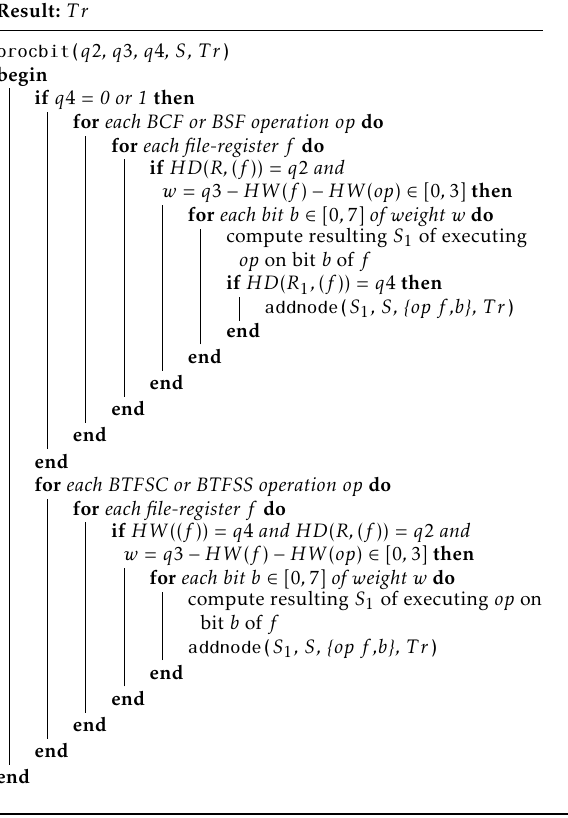
file register instructions (including conditional branch BTFSC and BTFSS ) that satisfy ( q 2 , q 3 , q 4). Some optimizations